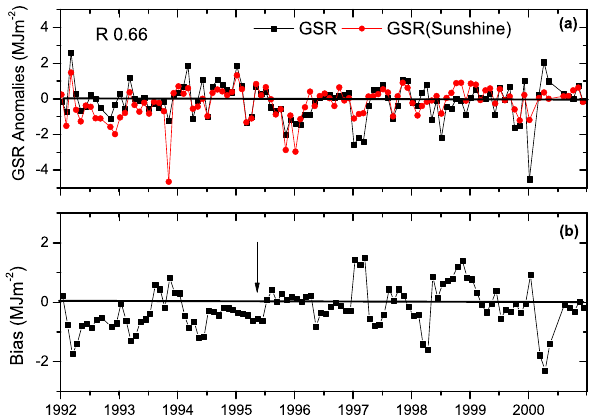
Figure 5. Times series of monthly median of (a) the deseasonalized